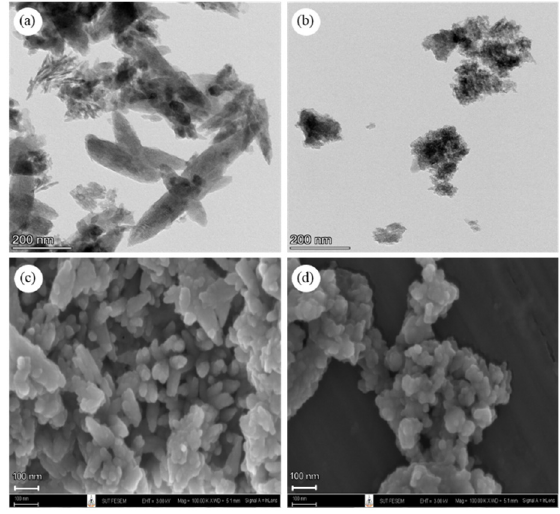
Figure 6. FE − TEM images of ( a ) 1DP − nHAp and ( b ) 2DP − nHAp and FE − SEM images of ( c ) 1DP − nHAp and ( d ) 2DP − nHAp .